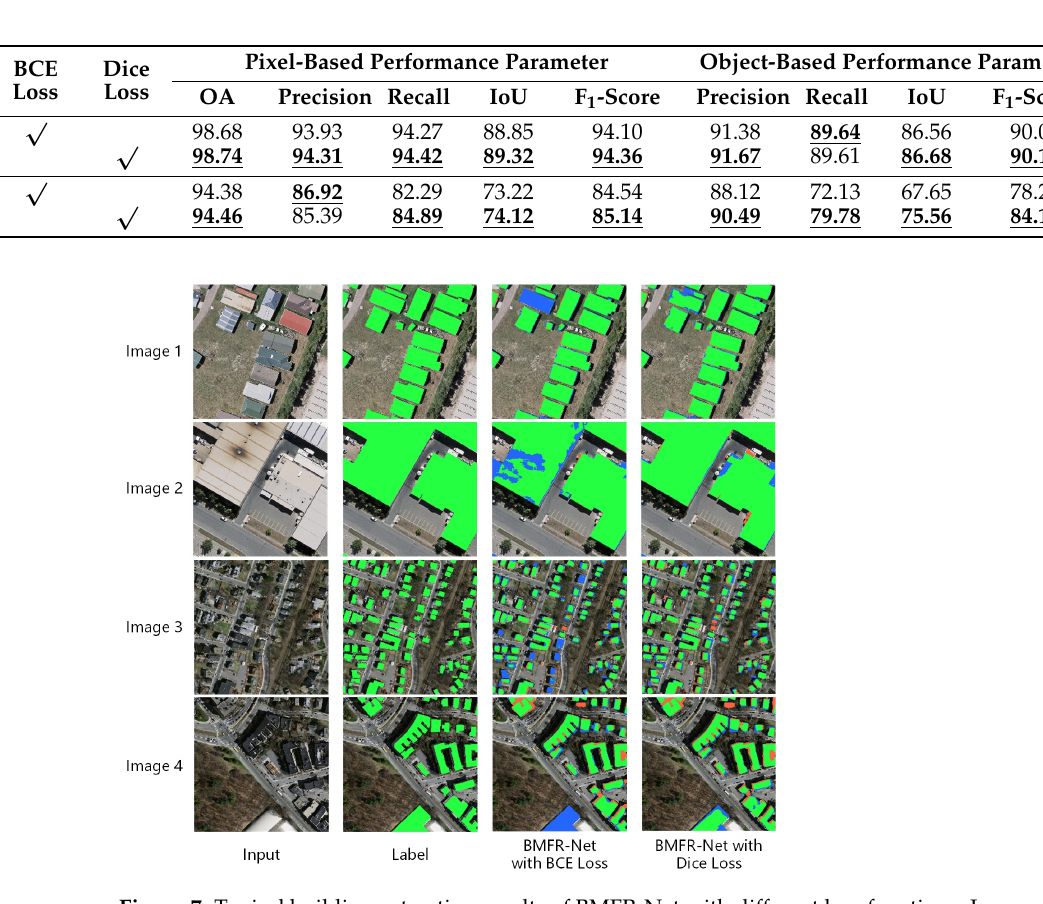
Figure 7. Typical building extraction results of BMFR-Net with different loss functions. Images 1 and 2 belong to the WHU Building Dataset and images 3 and 4 belong to the Massachusetts Building Dataset. In the graph, green represents TP, red represents FP, and blue represents FN.